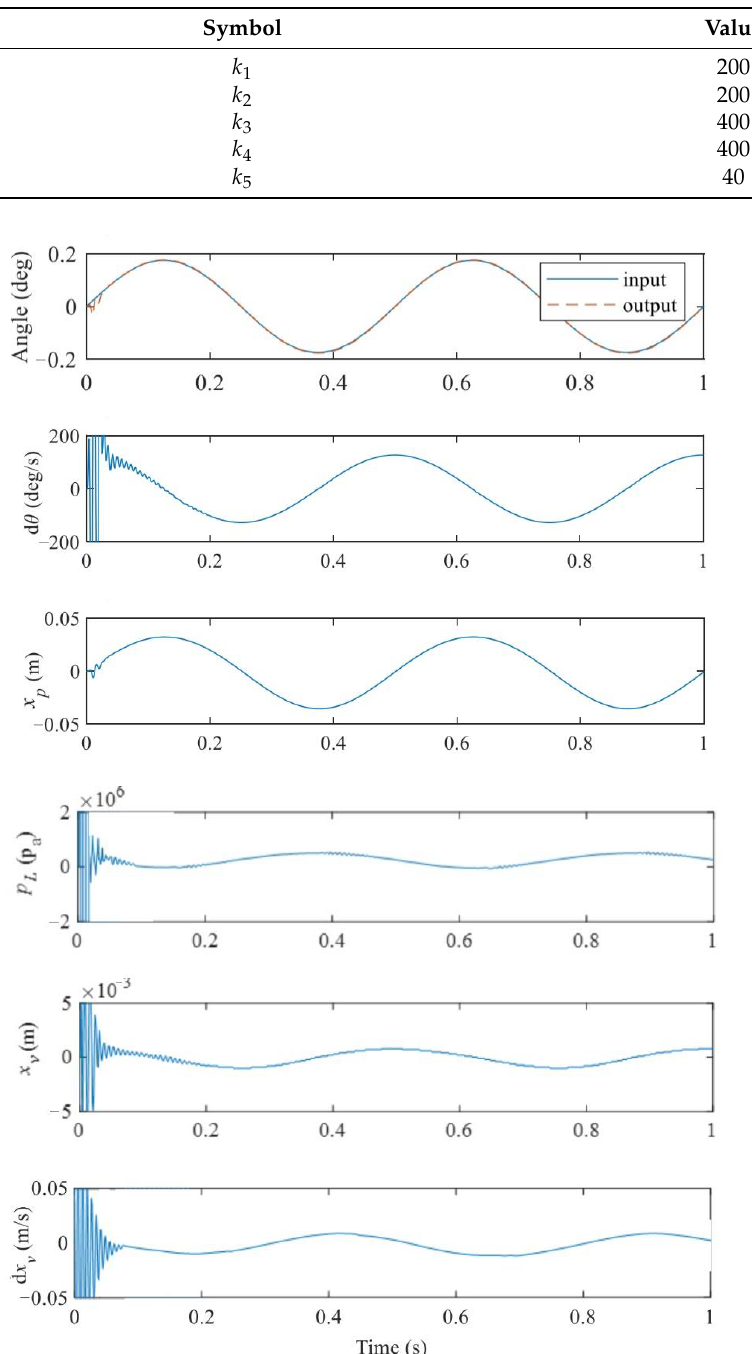
Table 6. The second set of backstepping control parameters.